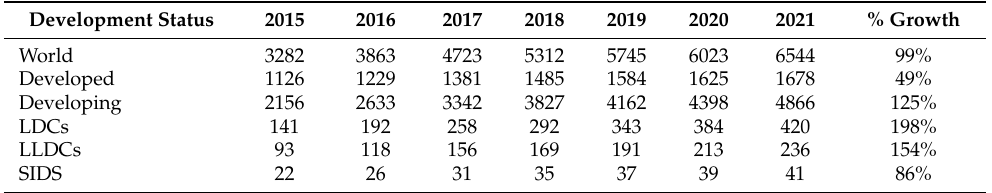
Growth in active mobile broadband (3G and above) subscription in millions by development